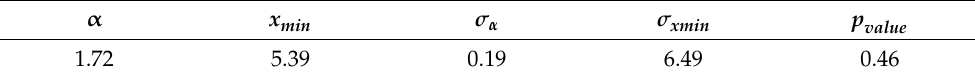
Table 2. Parameters of the power-law model for the inter-event time dataset.